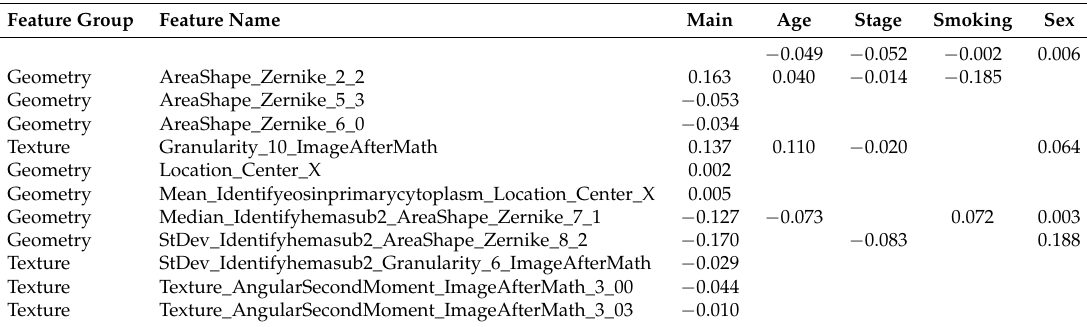
Table 2. Joint analysis of FEV1: identified main effects and